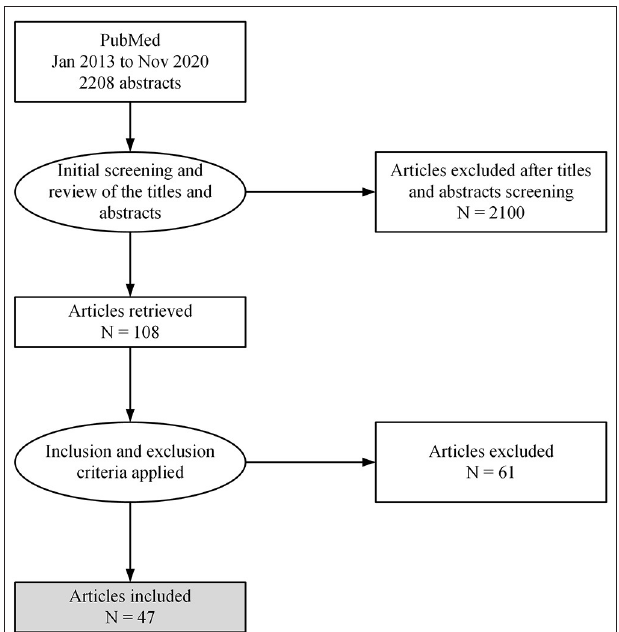
FIGURE 1 | Flowchart representing the process of literature review from the